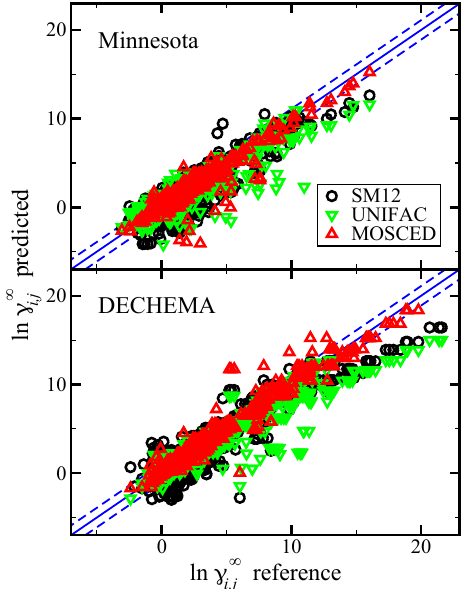
Figure 9. Parity plot of the predicted versus reference values of ln γ ∞ universal solvent model, Universal Quasichemical Functional-group Activity Coefficients (UNIFAC), and modified separation of cohesive energy density (MOSCED) versus reference data from the Minnesota Solvation Database version 2012 (top pane) [47] and DECHEMA (bottom pane) [50–55], as indicated. The blue lines corresponds to the y = x line, and the dashed blue lines correspond to ± 1.1 and are drawn as a reference. For the SM12 universal solvent model predictions, ∆ G self